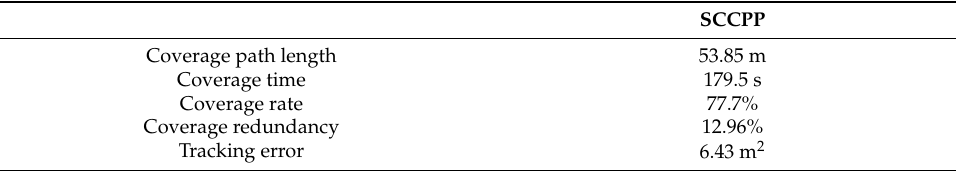
Table 3. SCCPP algorithm on the Pioneer 3DX robot for the Lab scenario